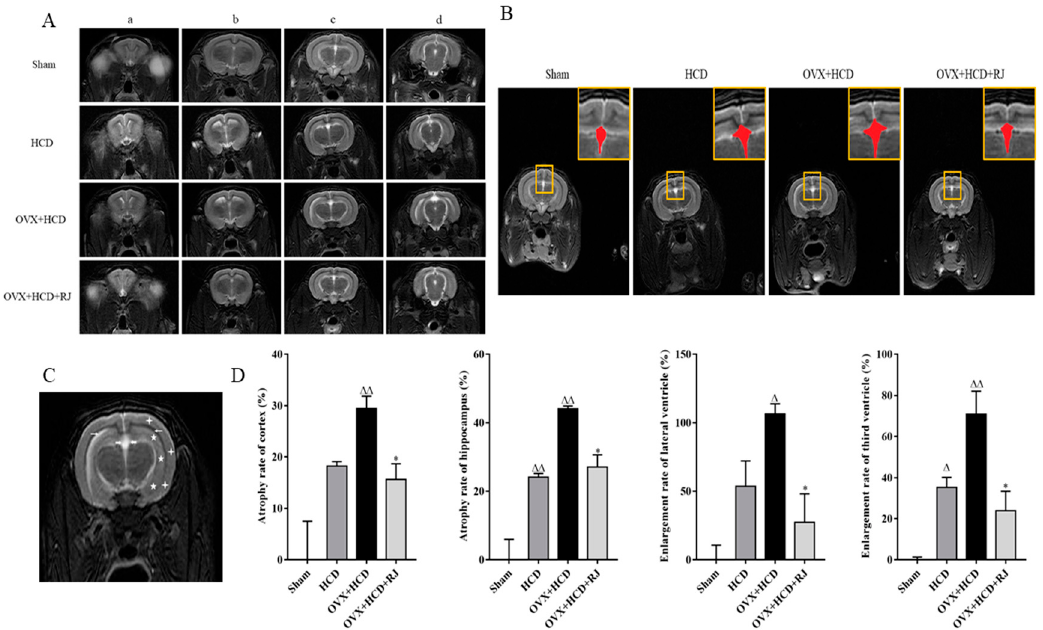
Figure 5. RJ improved the structure of brain MRI T2W image in ovariectomized cholesterol-fed rabbits. ( A ) T2W images on rabbit brain of OVX + HCD, HCD, OVX + HCD + RJ, and Sham group at different levels from left to right: the level of the rostral part of the hypophysis ( a ), the caudal part of the hypophysis ( b ), the thalamus ( c ), and the mesencephalic aqueduct ( d ).( B ) The effect of RJ on the structure of the third ventricle in ovariectomized Alzheimer’s disease (AD) rabbits. Yellow square as enlarged view, red marks as the third ventricle area. ( C ) T2W image from a rabbit received high-cholesterol diet in ovariectomized rabbits. The cortex (white cross), hippocampus (white pentagram), the third ventricles (white dovetail arrow) and lateral ventricles (white arrow) were identified. ( D ) Quantitative analysis of changes in the cortex, hippocampus, lateral ventricle, and third ventricle in each group. The atrophy rate of cortex and hippocampus, as well as enlargement of the lateral ventricle and third ventricle, were detected by quantitative analysis. Data are expressed as mean ± SEM. n = 4. Compared with Sham group, ∆ P < 0.05, ∆∆ P < 0.01; Compared with OVX + HCD group, * P < 0.05, ** P < 0.01.